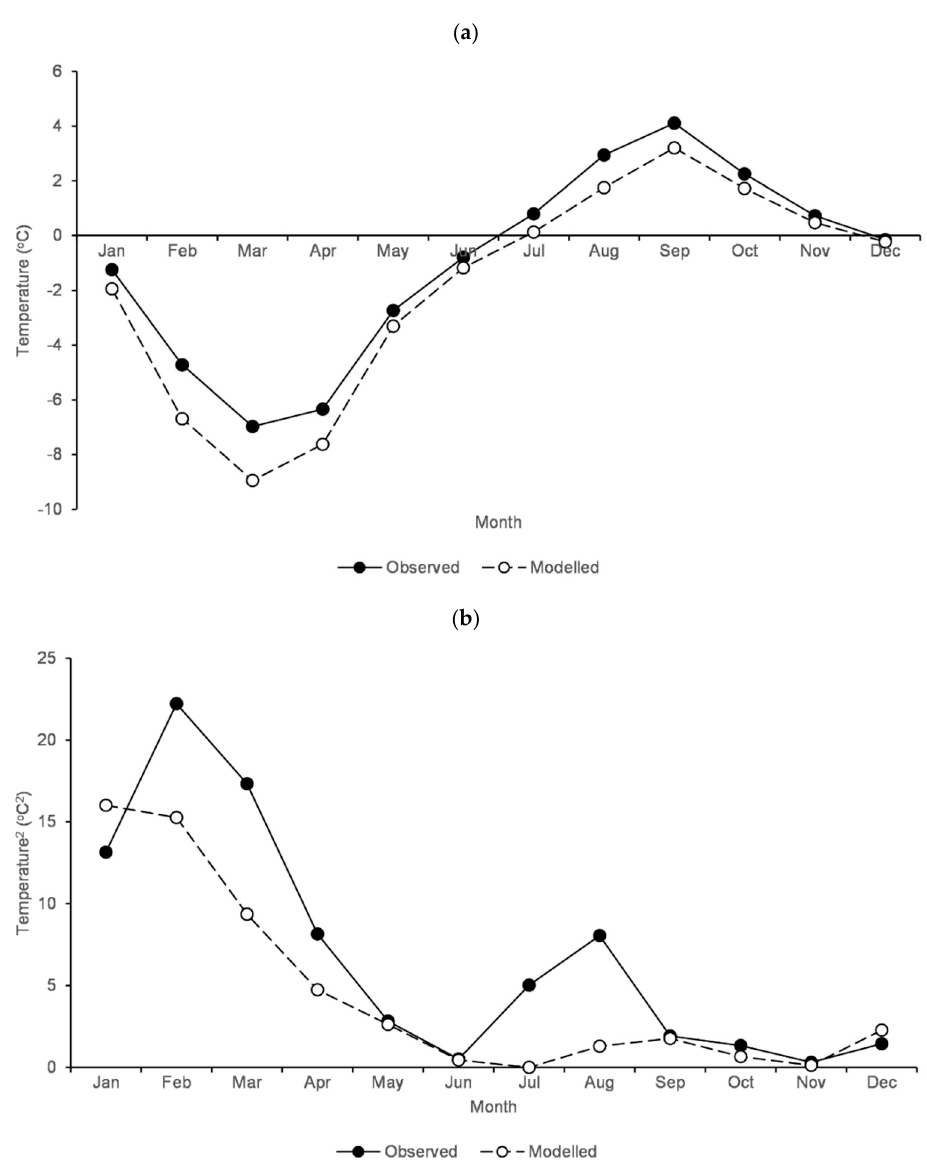
Figure 8. Comparison between the observed monthly 150 cm soil temperature and the predicted values from the CanESM2 and NCEP models for: ( a ) mean; ( b ) variance.